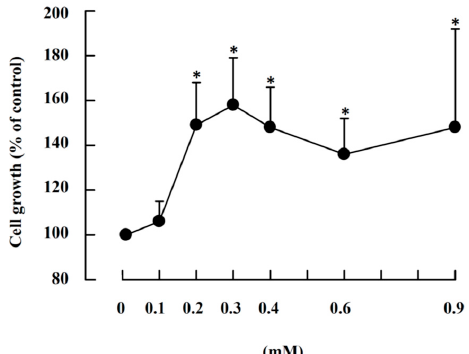
Figure 6. Effects of ZnCl 2 concentrations on the growth of the 5.1 μ m cells in the rat bone marrow cell culture. Rat bone marrow cells were suspension-cultured with 0.01 mM ZnCl 2 (control) to 0.9 mM ZnCl 2 in the presence of medium and 10% rat serum. After 24 h, the harvested cells were measured with a cell counter. Cell growth is expressed as the ratio of the number of 5.1- μ m cells at the start of the culture compared with that of the control. The results are the mean ± SD from six independent experiments. *, significant difference between the ZnCl 2 supplemented and control ( p < 0.05, n = 6).